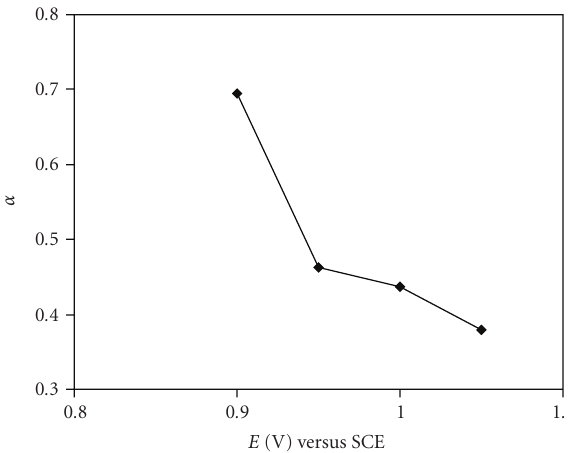
Figure 6: Potential dependences of the polarizability of the trans- passive film/solution interface. This parameter is acquired from (29).